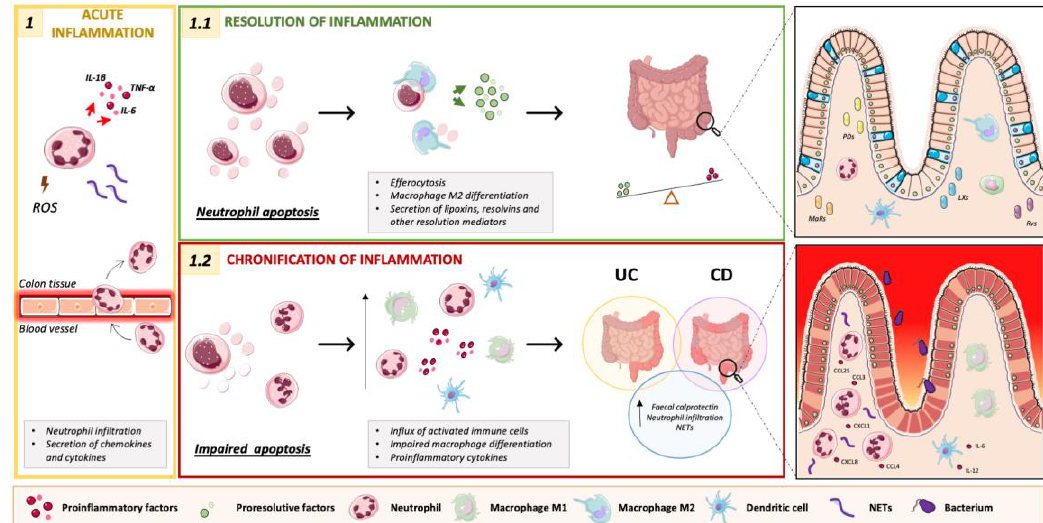
Figure 1. Schematic representation of the functions developed by neutrophils during inflammation. 1. Neutrophils secrete pro-inflammatory mediators during the acute inflammatory response. 1.1. Neutrophil apoptosis and efferocytosis, with the production of pro-resolutive factors, lead to the resolution of inflammation. 1.2. Persistent neutrophil infiltration and low apoptotic rates contribute to the chronification of intestinal inflammation.